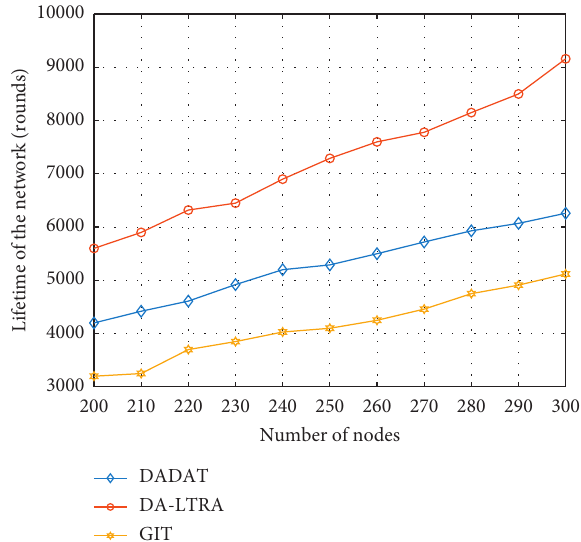
Figure 9: Lifetime comparison under different numbers of